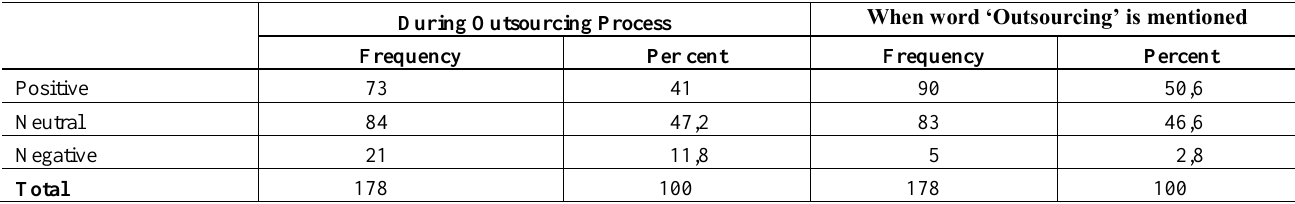
Table 3: Employees feelings towards